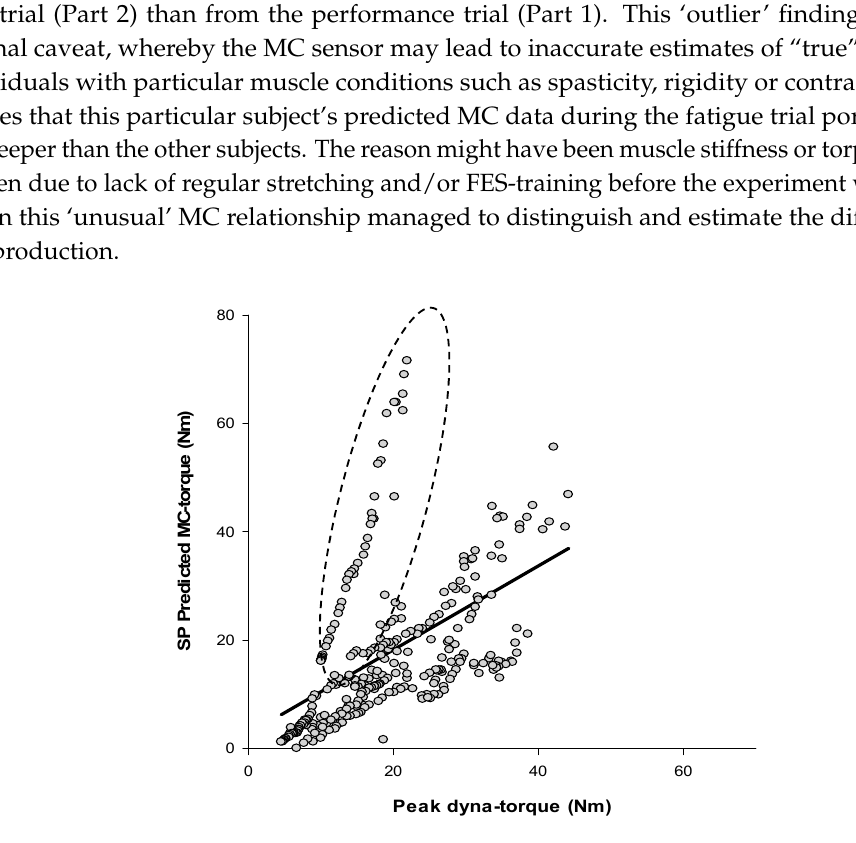
Figure 9. Regression analysis between Peak dyna-torque and SP predicted MC during the muscle fatigue experiment; includes 1 subject (data in dashed circle).